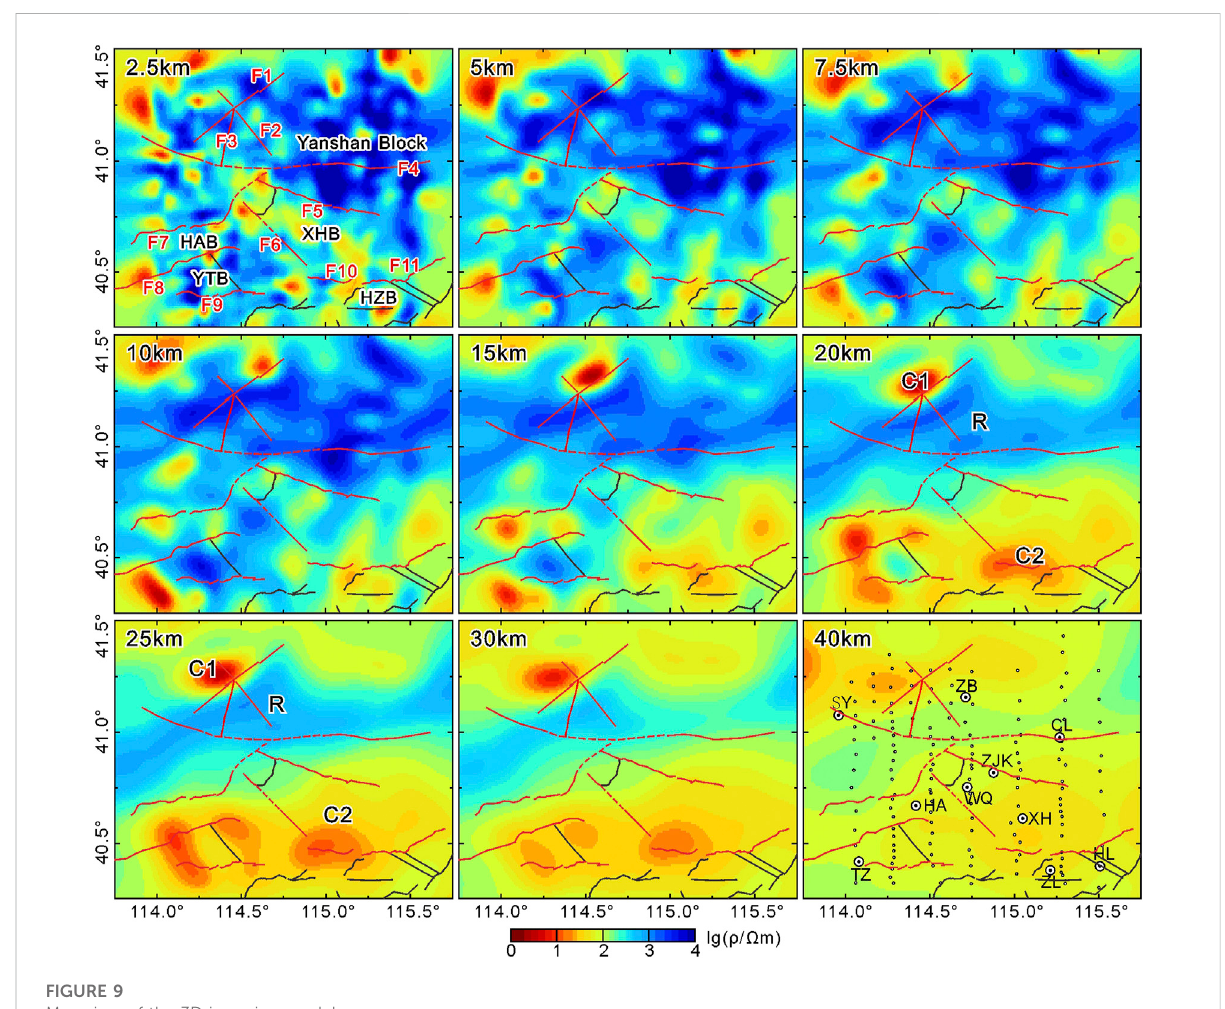
FIGURE 9 Map view of the 3D inversion